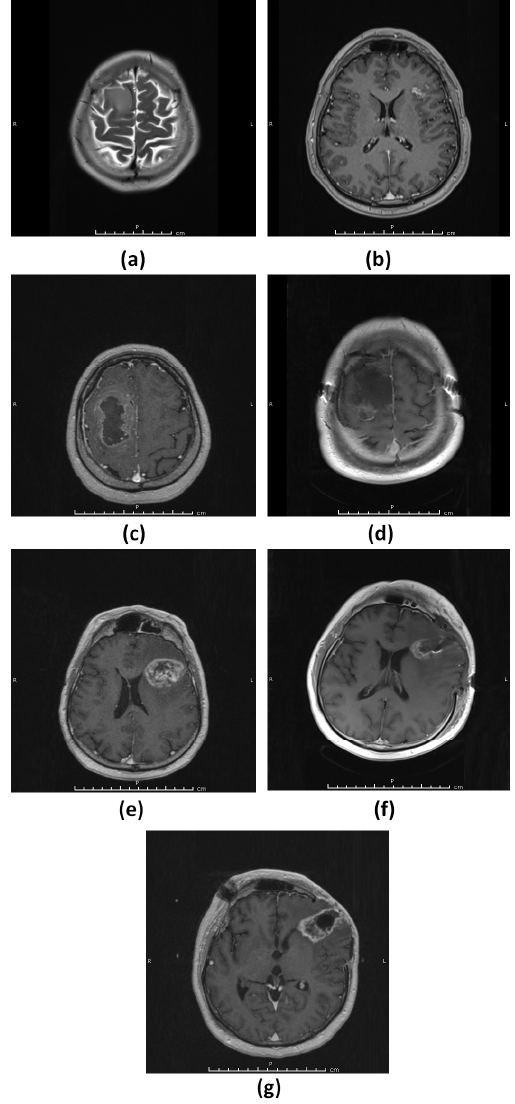
Figure 3. Patient 3 (G3–4). ( a ) T2-weighted MRI showing a hyperintense lesion consistent with a low-grade glial tumor in the right frontal region. ( b ) T1-weighted MRI showing a small contrast-enhancing lesion in the left frontal lobe. ( c ) T1-weighted MRI showing rapid growth and malignant transformation of the untreated right frontal tumor. ( d ) T1-weighted MRI showing gross total resection of the tumor. ( e ) T1-weighted MRI showing the progression of the left frontal tumor. ( f ) T1-weighted MRI showing gross total resection of the tumor. ( g ) T1-weighted MRI showing rapid recurrence of the left frontal tumor.